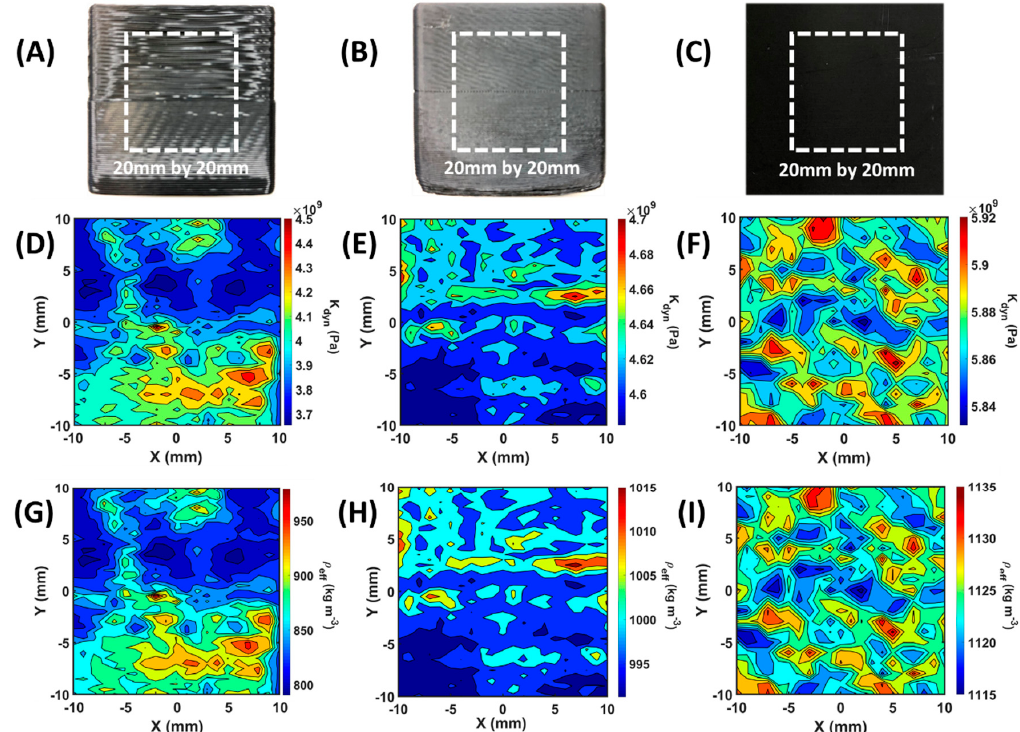
Figure 4. Dynamic bulk modulus imaging and effective density maps from immersion ultrasonic